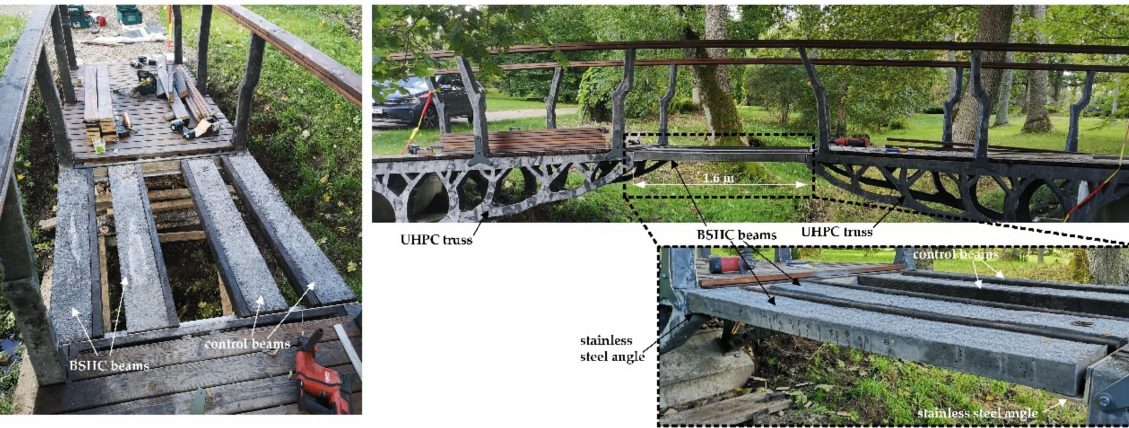
Figure 6. Biological and control beams installed in the bridge for long-term inspection of crack